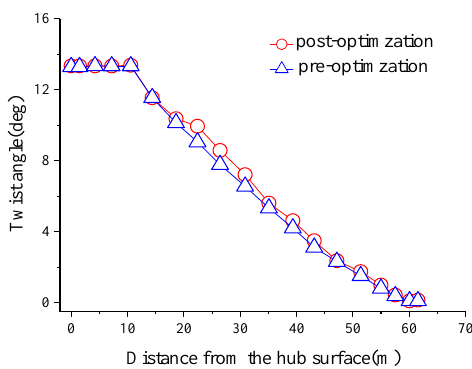
Figure 13. Distribution of the twist angle at rated wind speed before and after optimization.